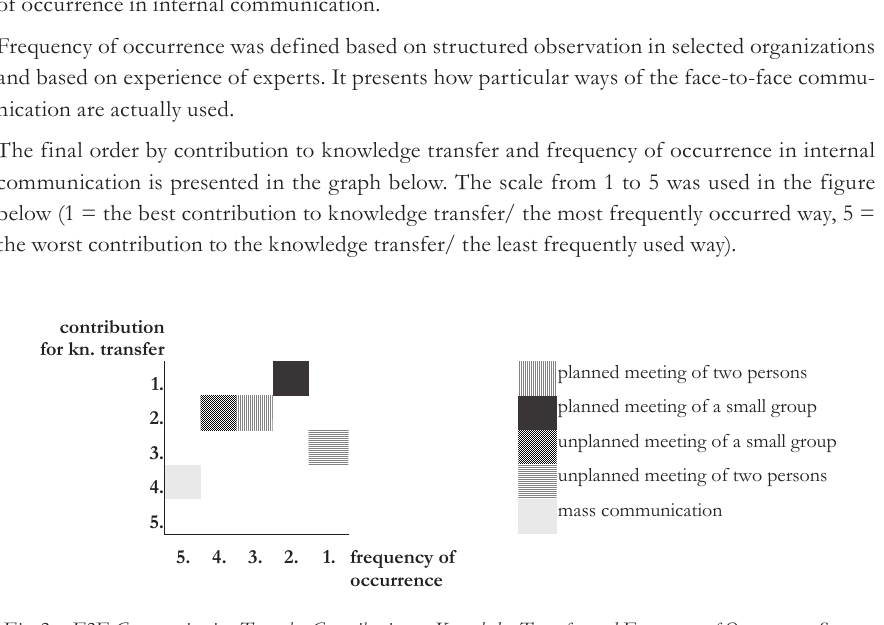
Fig. 2 – F2F Communication Types by Contribution to Knowledge Transfer and Frequency of Occurrence. Source: own